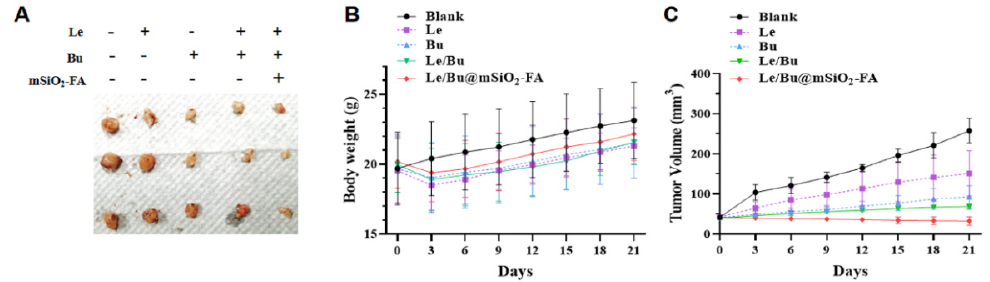
Figure 6. ( A ) Photographs of excreted tumor after different treatments. ( B ) Body weight change of treated mice of different treatments during treatment periods. ( C ) Tumor volume statistics of each group of tumor-bearing mice. N = 3 of each group.